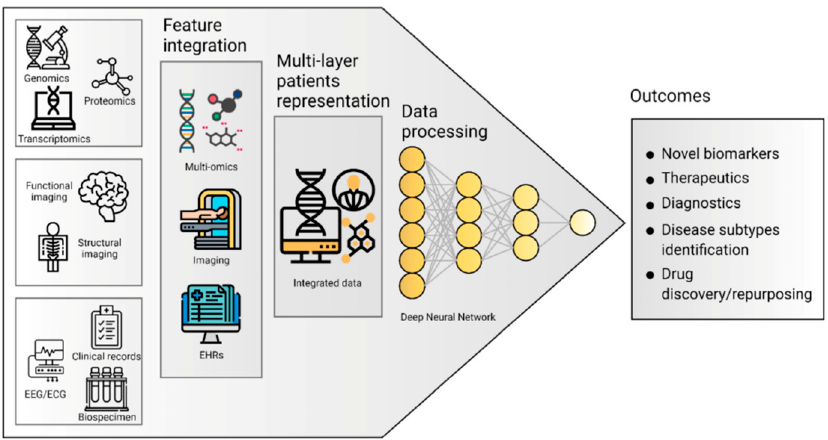
Figure 3. A multilevel approach to working with data on neurodegenerative disorders [4].